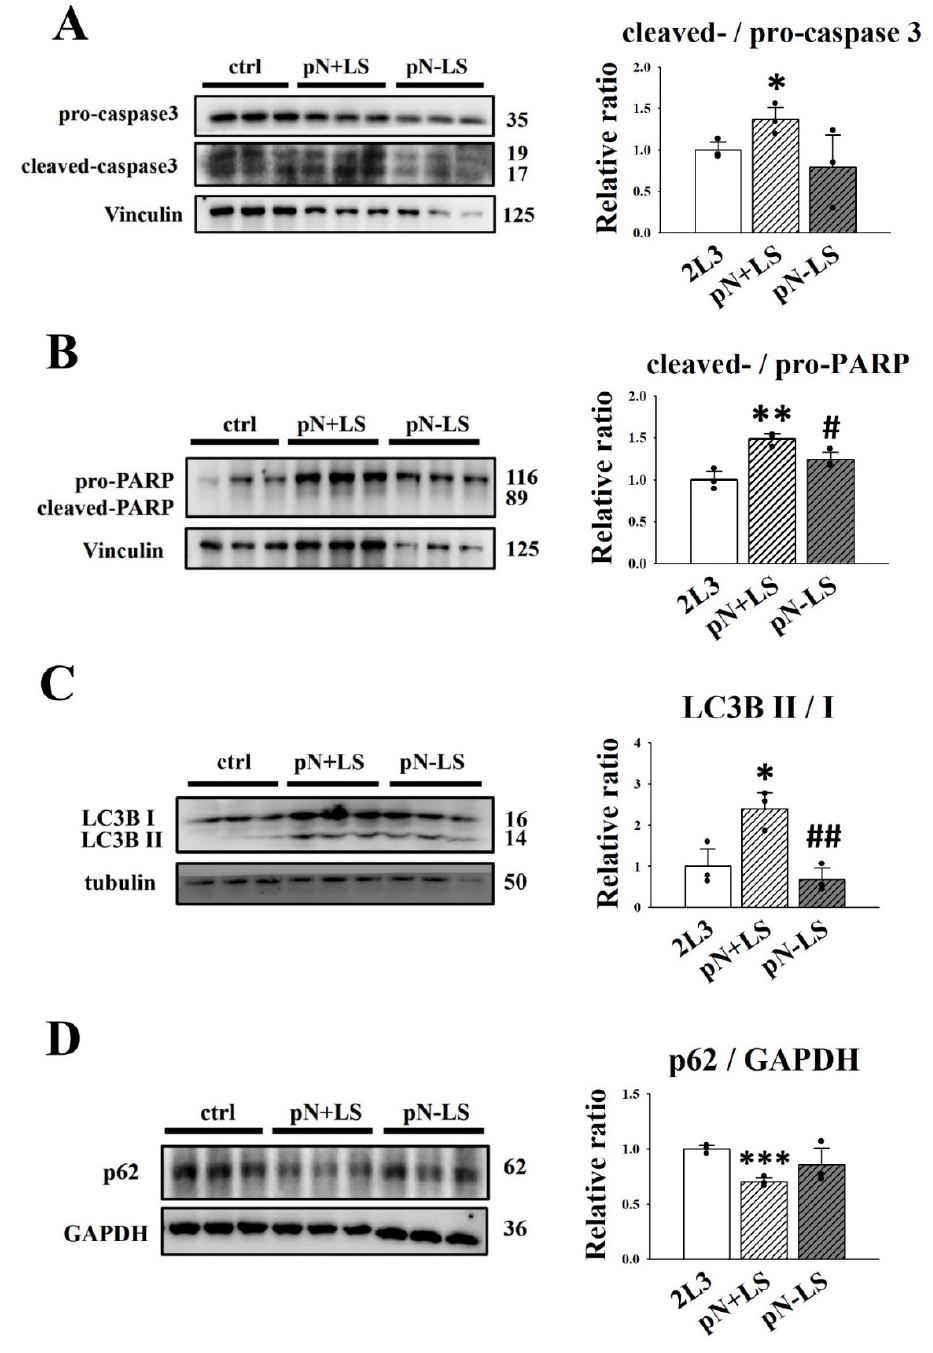
Figure 9. Effects of overexpression of mNGAL protein on apoptosis and autophagy in 2L3 cells. Western blot results showed that pN + LS cells had significantly higher ratio of cleaved-/pro-caspase-3 ( A ) and cleaved-/pro-PARP ( B ) than the control group, which represented the induction of apoptosis by secreted mNGAL. pN − LS cells had no significant difference in the ratio of cleaved-/pro-caspase-3 and cleaved-/pro-PARP compared with the control group. pN + LS cells had a higher ratio of LC3B II/LC3B I ( C ) and the lower ratio of p62 ( D ) compared with the control group. pN − LS cells had no significant difference in ratio of LC3B II/LC3B I and p62 compared with the control group. Tubulin, Vinculin, and GAPDH were used as the internal controls of each sample. Values were normalized to the control group. Student’s t-test was performed to determine the significance between groups ( n = 3). * p < 0.05; ** p < 0.01; *** p < 0.001 vs. control group; # p < 0.05; ## p < 0.01 vs. pN + LS group.